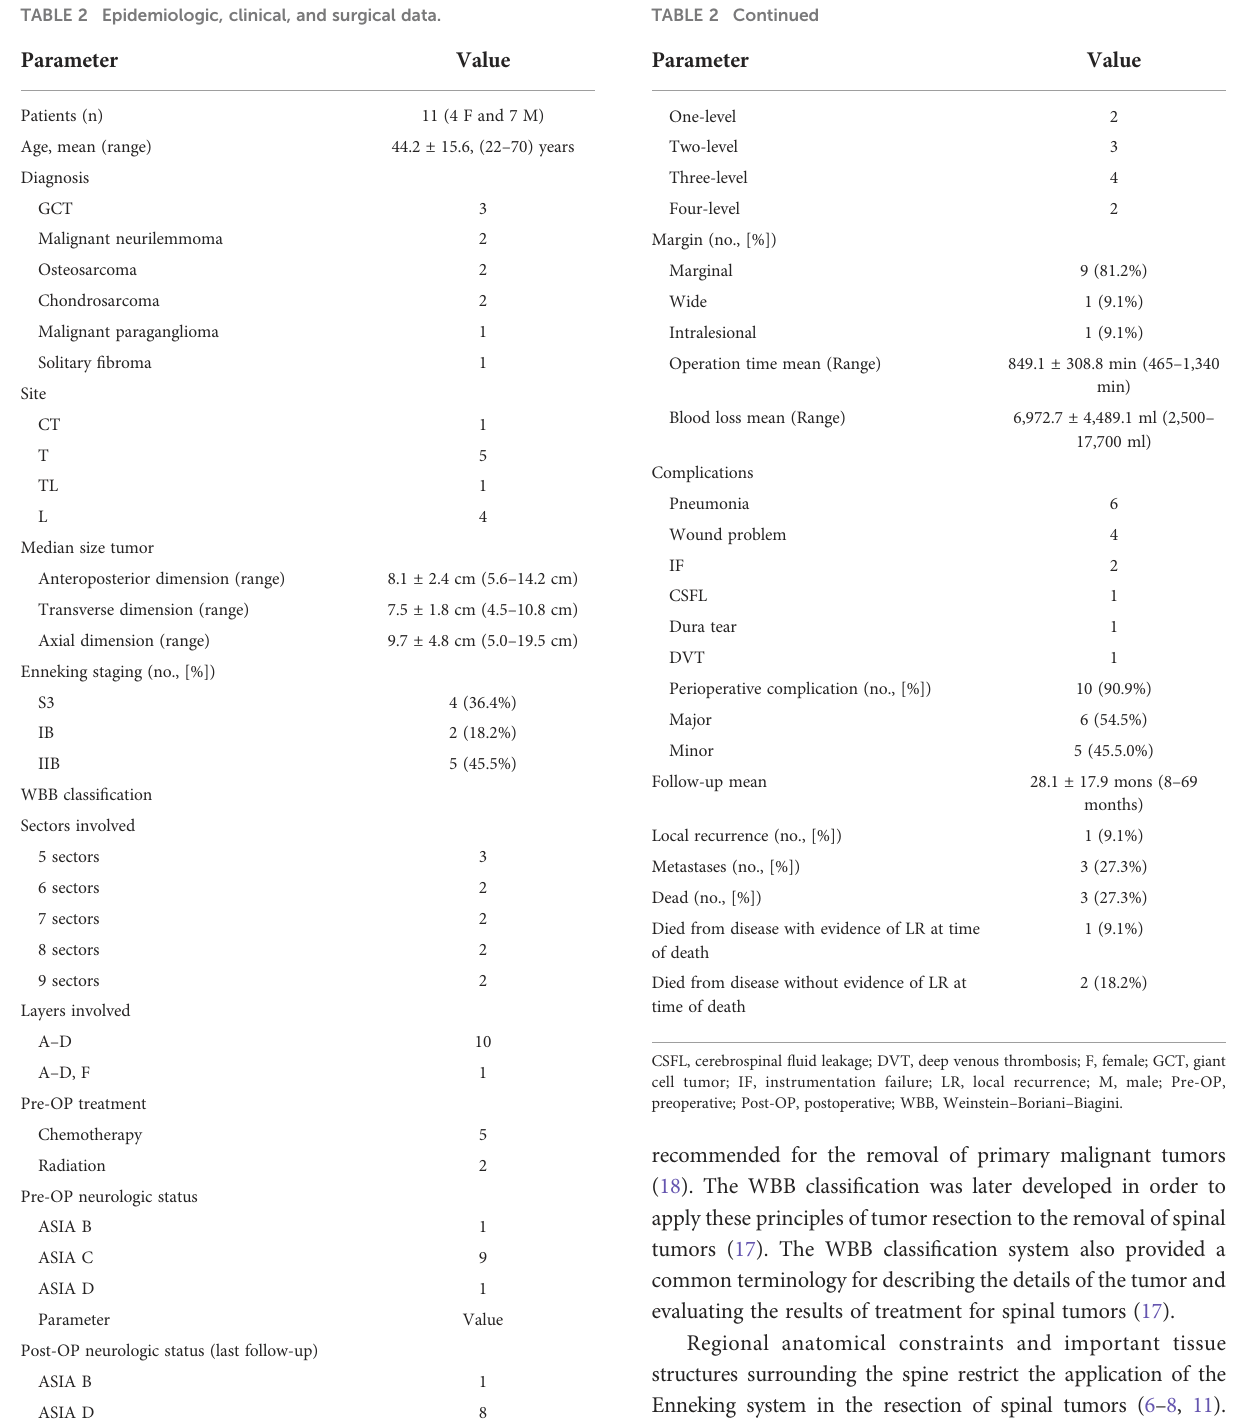
TABLE 2 Epidemiologic, clinical, and surgical